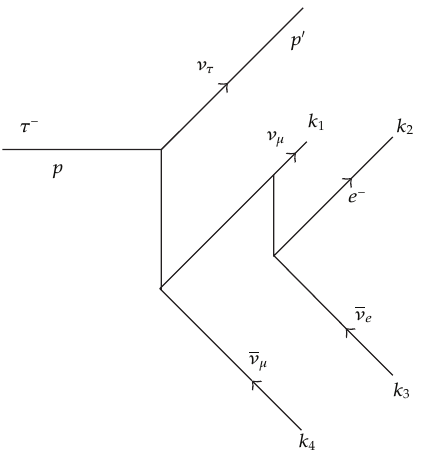
Figure 6: Tau lepton decay